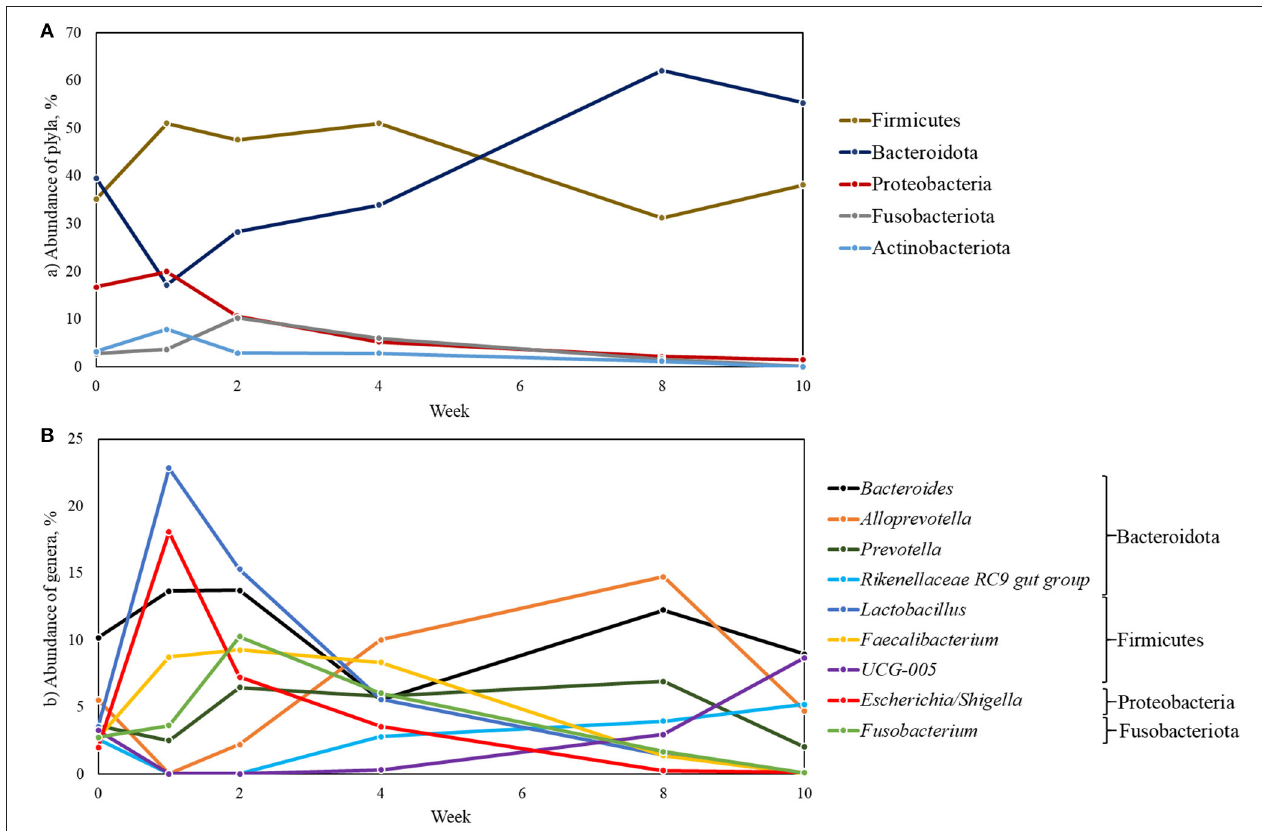
FIGURE 5 | Relative abundance of bacterial phyla (A) and genera (B) in fecal samples during pre- and post-weaning in dairy calves fed different liquid